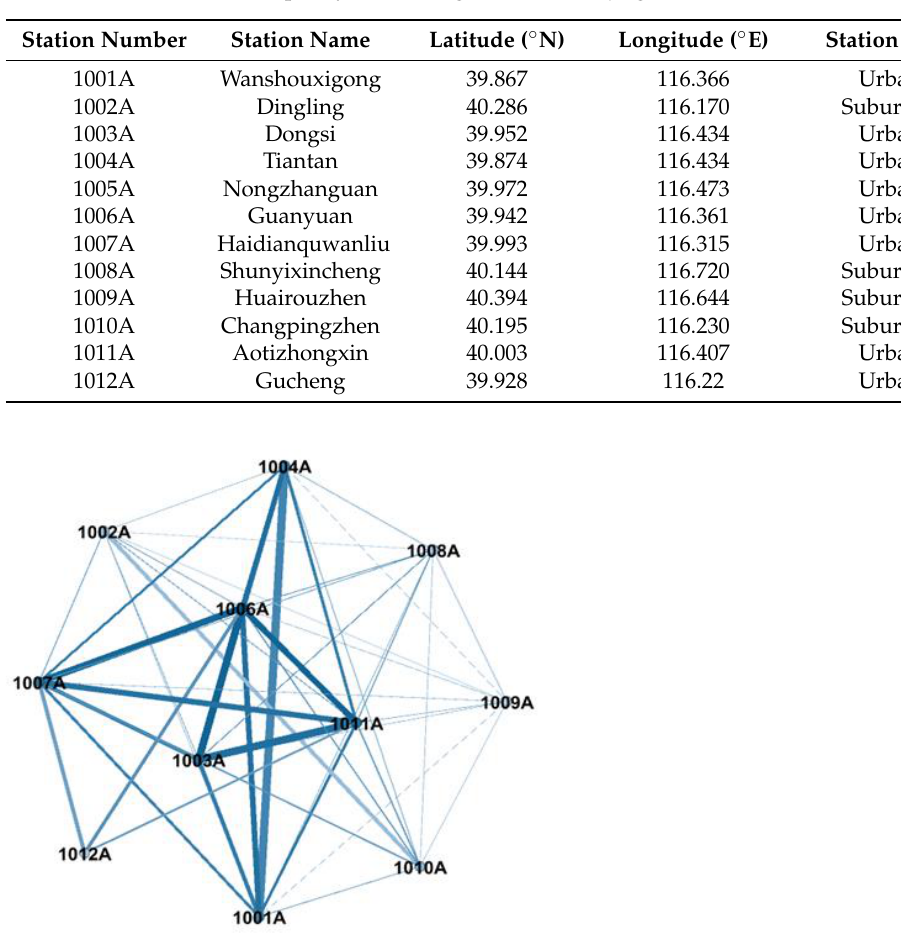
Table 3. Information on air quality monitoring stations in Beijing.